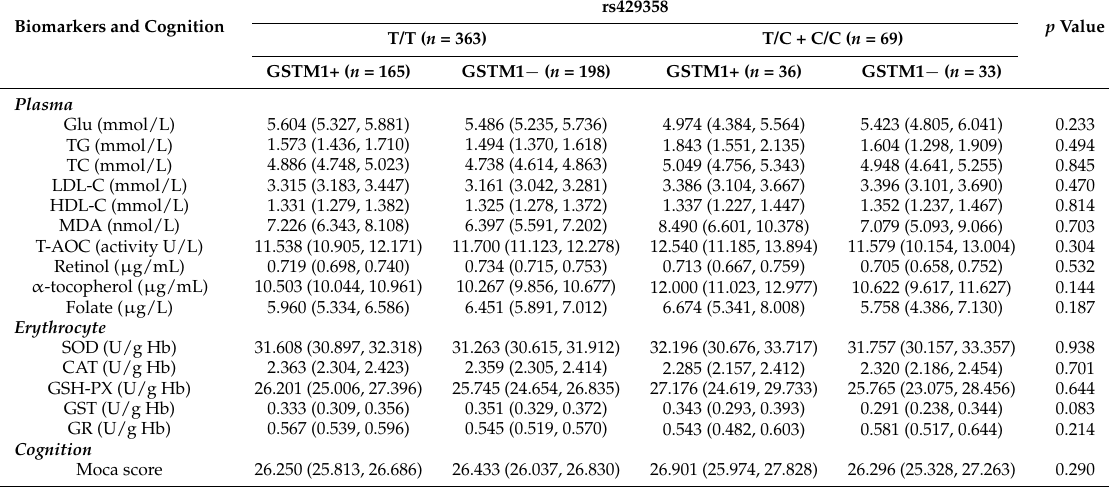
Plasma, erythrocytes parameters and cognition according to APOE rs429358 and GSTM1